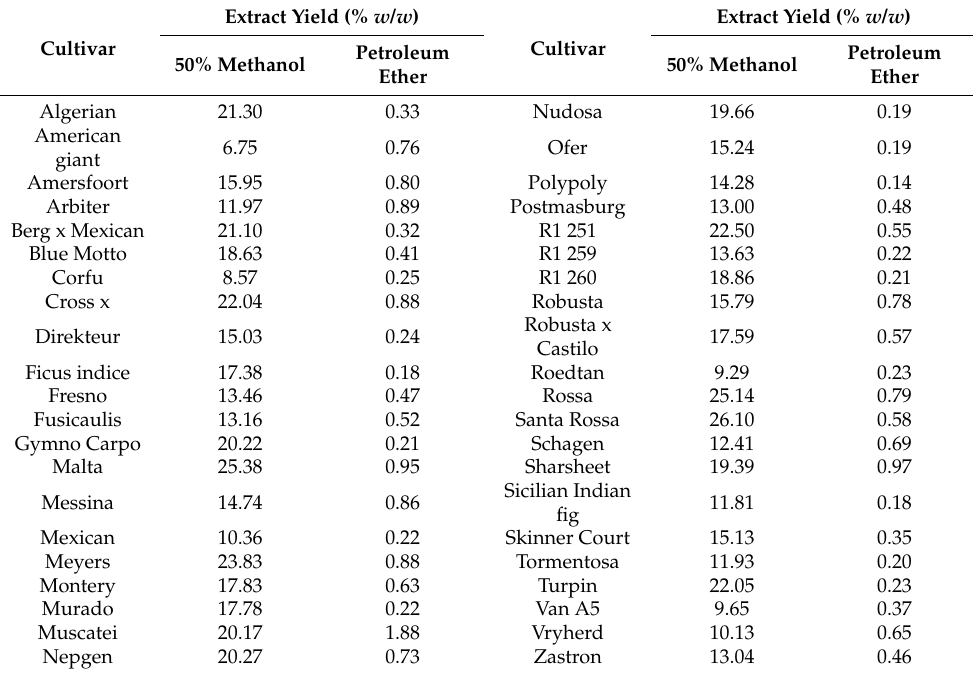
Table 1. Percentage yield of extracts from cladodes of 42 spineless cactus pear cultivars. Extract Yield (% w / w ) Extract Yield (% w / w ) Cultivar Cultivar Petroleum 50% Methanol 50% Ether